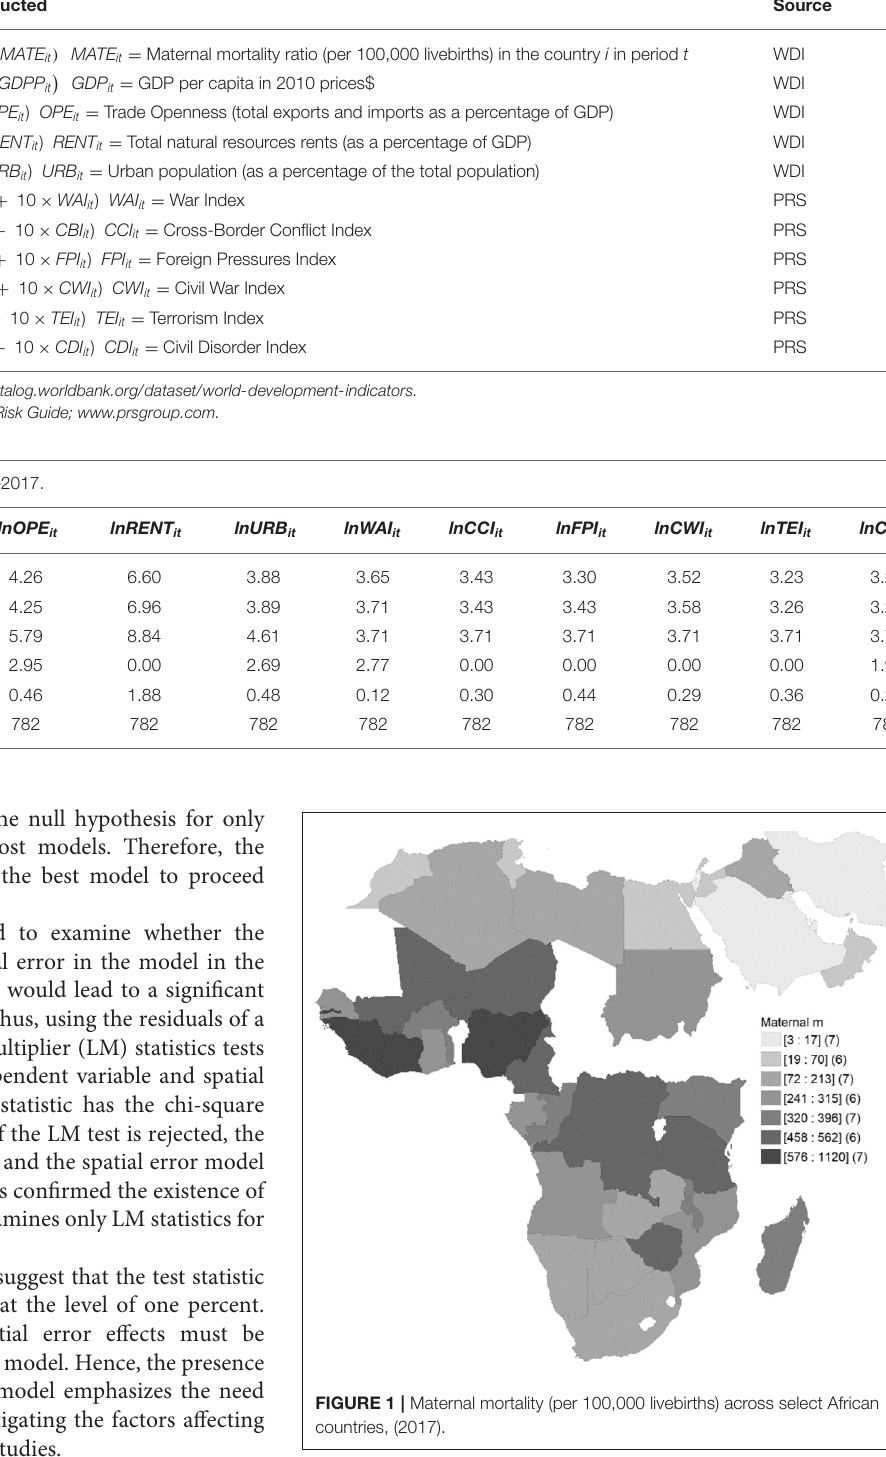
TABLE 1 | Variables used in the study. Variable Variable constructed